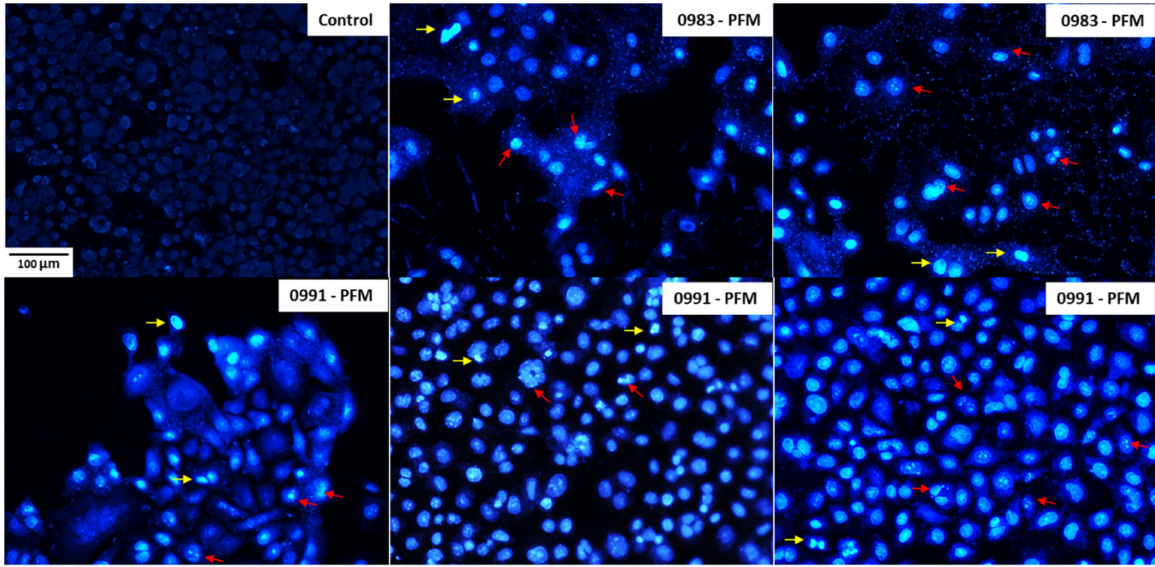
Figure 8. 4 (cid:48) ,6-Diamidino-2-phenylindole (DAPI) staining of Caco-2 cells exposed to post-fermentation media (PFM) of L. plantarum 0991 and L. brevis 0983 observed under a fluorescent microscope (Nikon Eclipse Ci H600L, Japan), 20 × objective. Arrows: red (chromatin fragmentation); yellow (chromatin